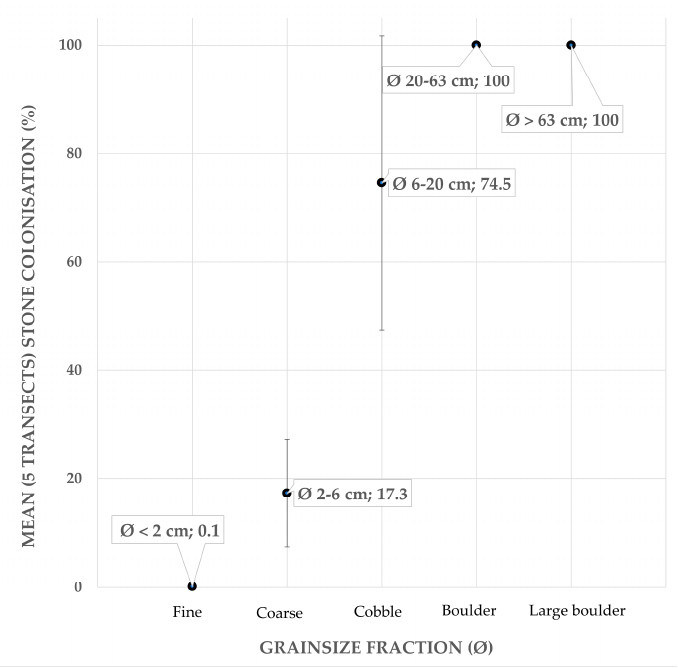
Figure 4. Average (across 5 transects) proportion of stone colonisation (%) by ISO 14688-1:2017 grain size classes. Bars displaying the standard deviation.